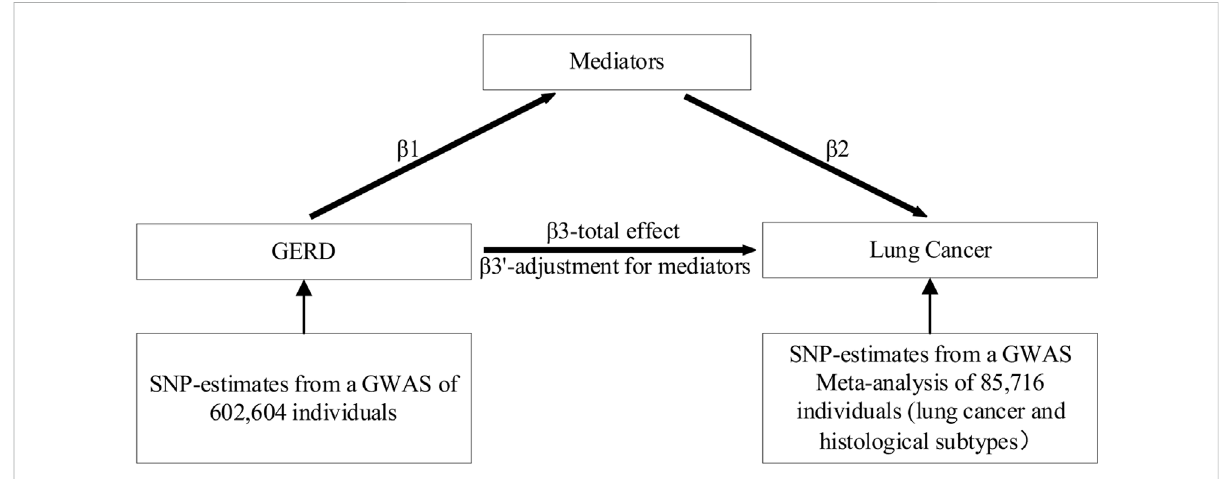
FIGURE 2 Graphical representation of the proposed mediation through mediators for the association of GERD with lung cancer. β 1 represents the regression coef fi cients for the association between GERD and mediators; β 2 represents the regression coef fi cients for the association between mediators and lung cancer; β 3 represents the total effect between GERD and lung cancer, without the adjustment for mediators; and β 3 ’ represents the direct effect between GERD and lung cancer, taking into account the adjustment for